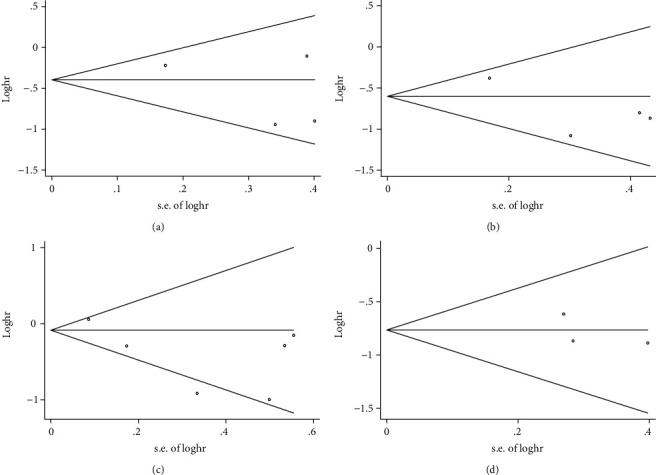
Begg's funnel plot of OS for publication bias. (a) Begg's funnel plot for PER1 protein expression and OS (pBegg's = 0.734). (b) Begg's funnel plot for PER2 protein expression and OS (pBegg's = 0.734). (c) Begg's funnel plot for PER2 mRNA expression and OS (pBegg's = 1.000). (d) Begg's funnel plot for PER3 protein expression and OS (pBegg's = 1.000).